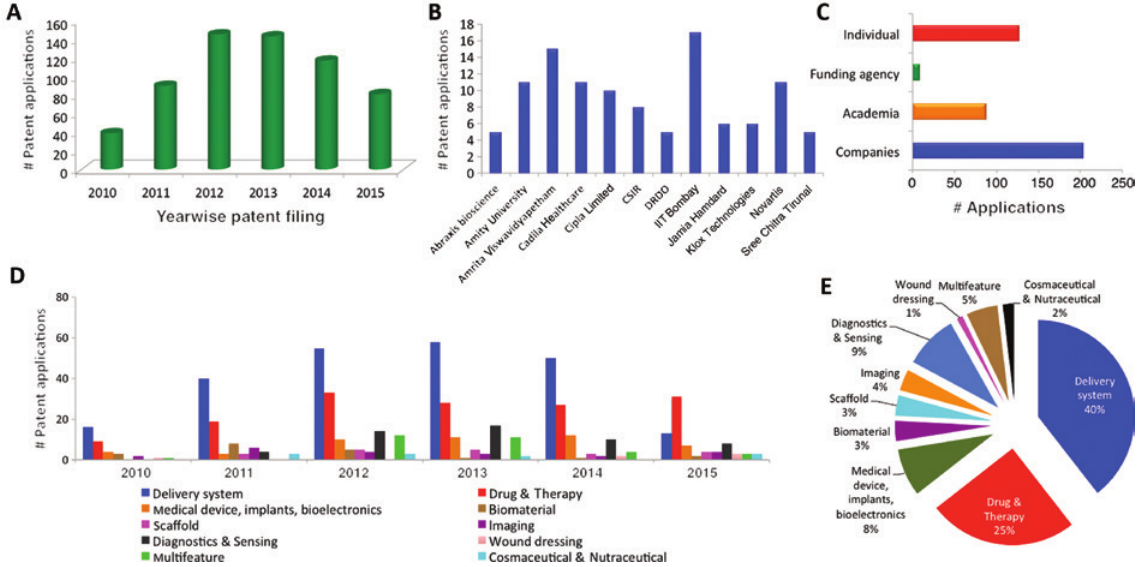
Figure 9: Filing trend of patent applications and key players in the field of nanomedicine in India. (A) Yearwise patent filing. (B) Key appli- cant filing patents in the field of nanomedicine. (C) Number of patent application category wise. (D) Areawise distribution of patent applica- tions over a period from 2010 to 2015. (E) Areawise distribution of total patent applications from 2010 to 2015 (source: compiled by authors from Indian patent office.)